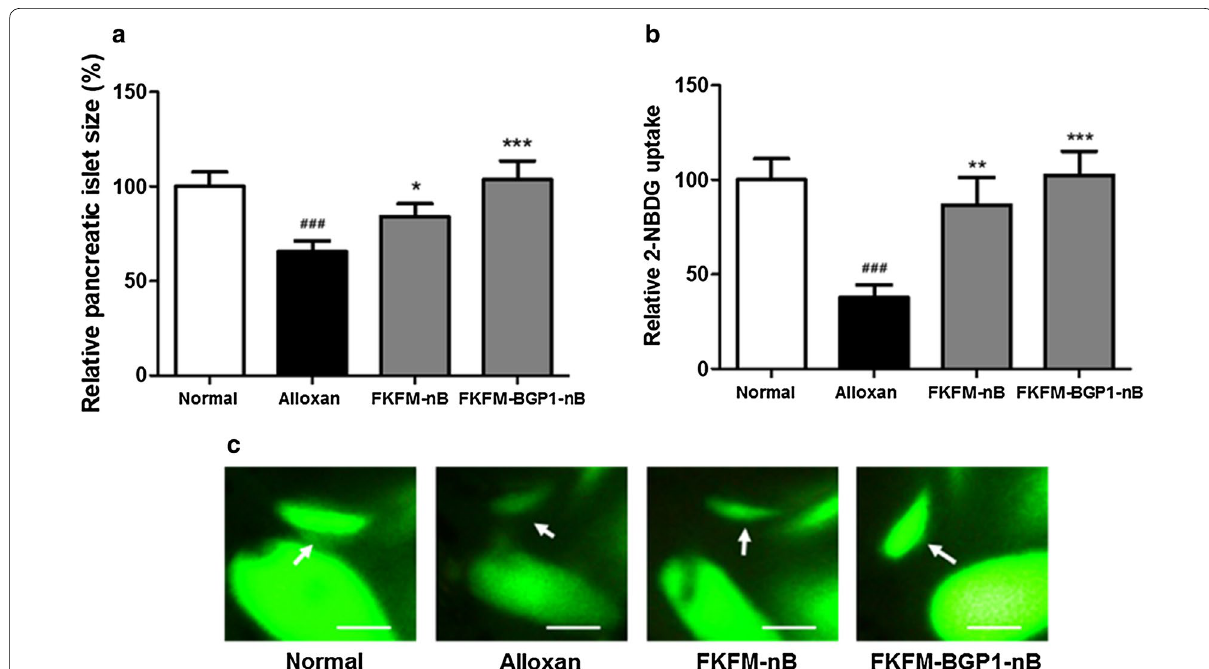
Fig. 5 Recovery effect of n ‑BuOH fractions from Forsythia koreana flowers MeOH extract (FKFM ‑ nB) and fermented FKFM (FKFM‑BGP1 ‑ nB) (1 μg/ mL) against AL‑induced PI in ZF. a Relative size of PI of each group. b Relative 2‑NBDG uptake of PI. c PI images. Data are expressed as mean ( ### p < 0.001; compared to normal), (* p < 0.05, ** p < 0.01, *** p < 0.001; compared to AL). Scale bar